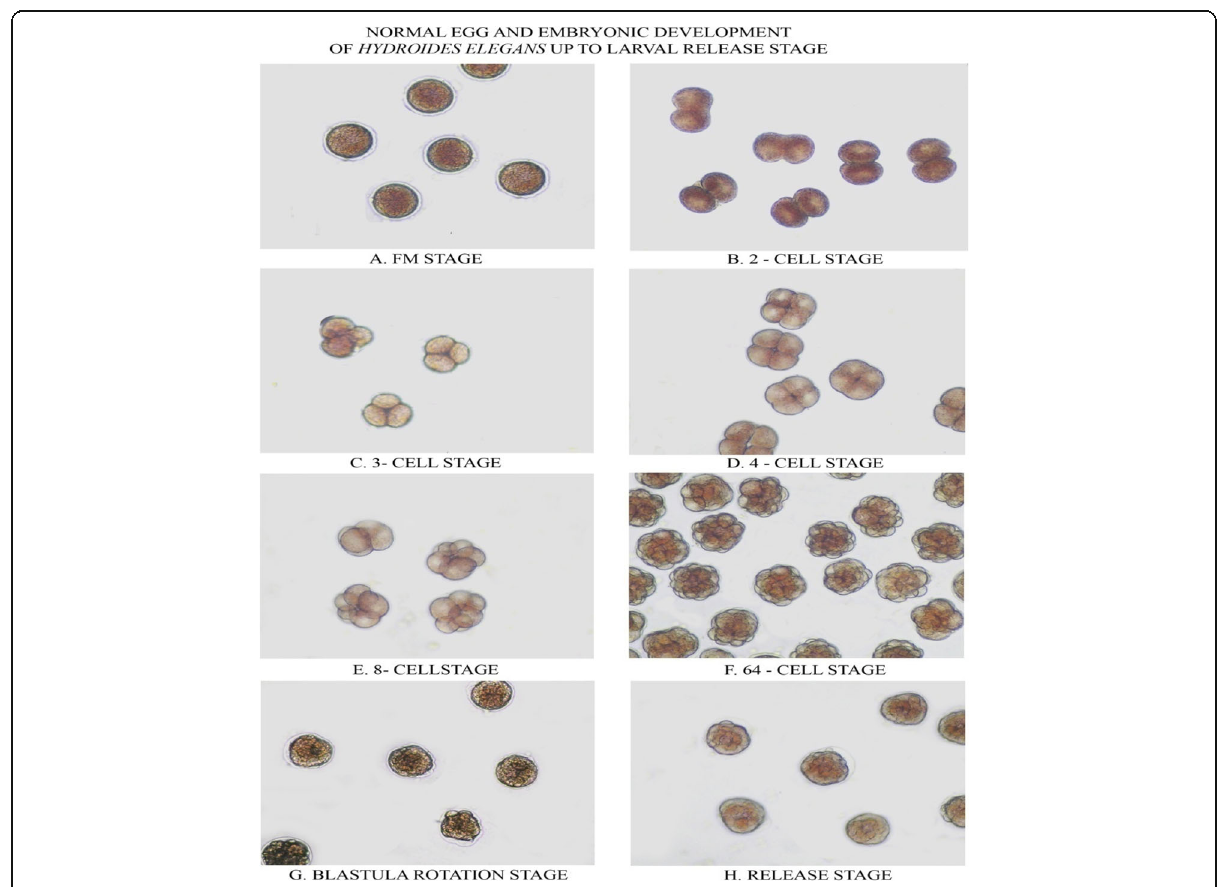
Fig. 5 Normal embryonic development of Hydroides elegans up to the larval stage. a FM stage. b 2-cell stage. c 3-cell stage. d 4-cell stage. e 8-cell stage. f 64-cell stage. g Blastula rotation stage. h Release